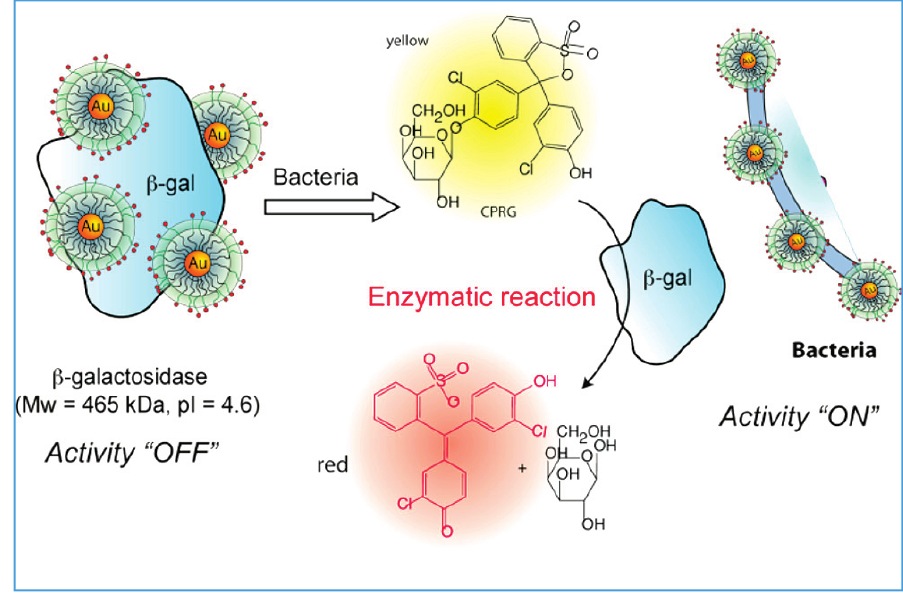
Figure 5. The schematic representation of the sensing mechanism of the colorimetric enzymatic nanocomposite biosensor for the detection of E. coli (reprinted with permission from [40]; copyright 2015 American Chemical